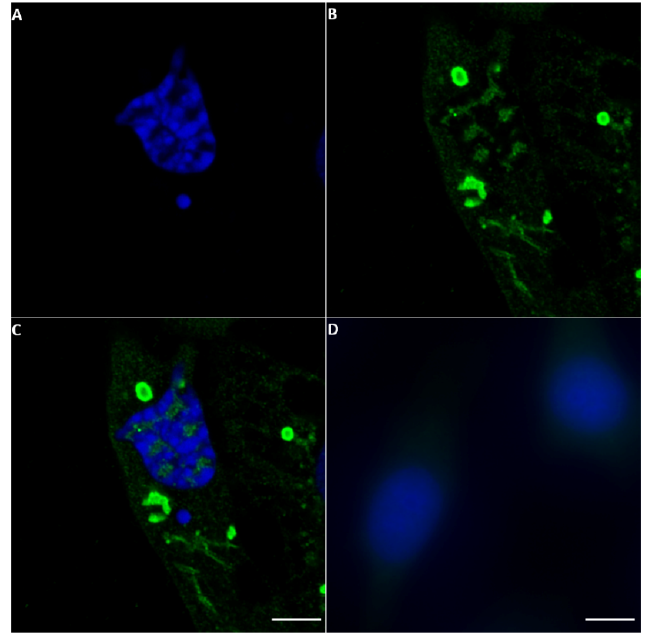
Figure 7. Immunofluorescence microscopy analysis of NS5 expression in AHSV-4 Morocco-infected BSR cells. Anti-NS5 antibodies from AHSV-4 identified NS5 in both the cytoplasm and nucleus of infected BSR cells by confocal microscopy. ( A ): nuclei coloured by DAPI. ( B ): NS5 is identified by anti-NS5 AHSV-4 antibodies and Alexa Fluor 488 (green fluorescence) conjugated anti-mouse IgG. ( C ): a merge of ( A , B ) panels and ( D ): non-infected BSR cells tested with anti-NS5 AHSV-4 antibodies and Alexa Fluor 488 conjugated anti-mouse IgG (negative for NS5 detection).